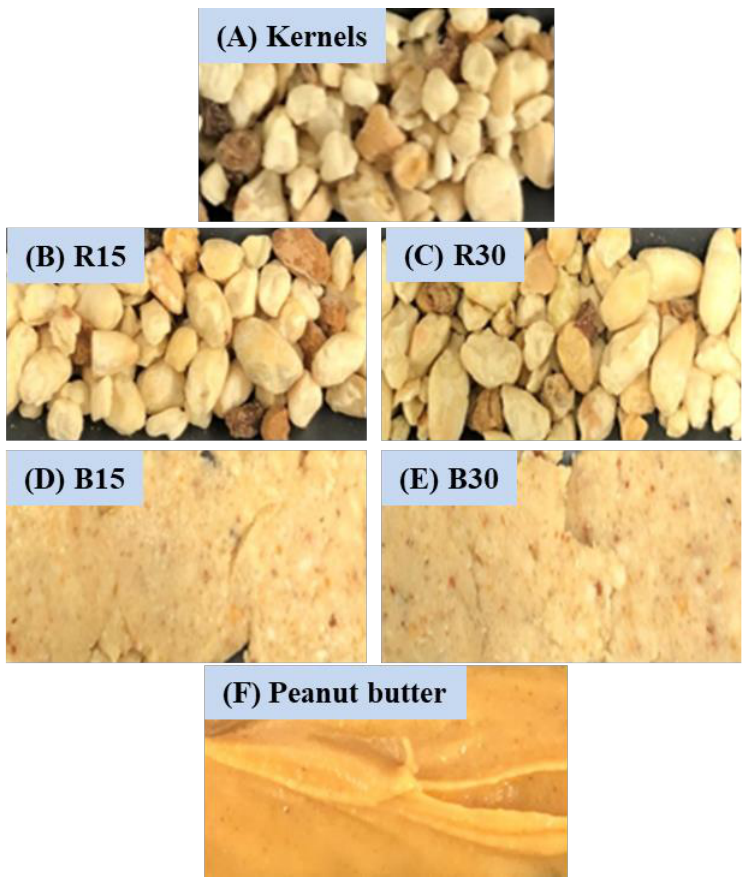
Figure 1. Images of unroasted glandless cottonseed kernels ( A ), kernels roasted at 150 °C for 15 min (R15) ( B ), 150 °C for 30 min (R30) ( C ), their corresponding butter products B15 ( D ) and B30 ( E ), and commercial Skippy creamy peanut butter ( F ).